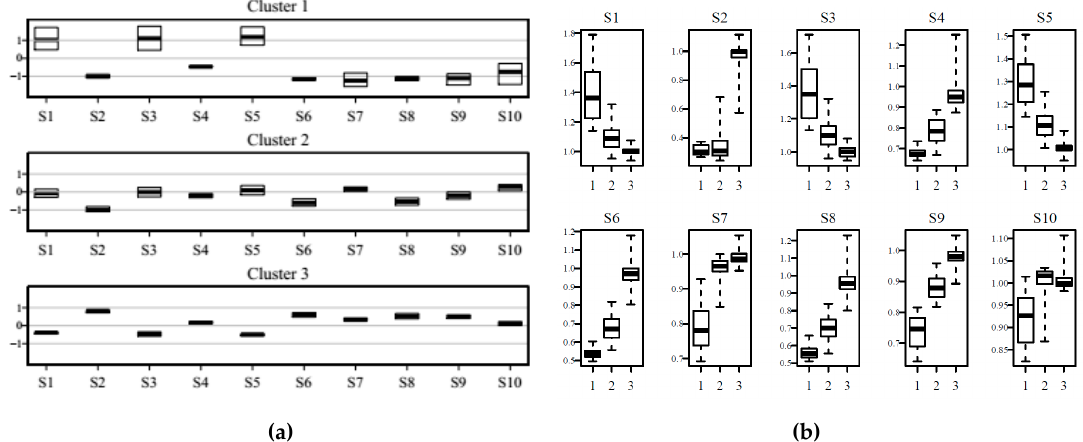
Figure 4. ( a ) Profiles of interquartile ranges and medians of sensor weights for prototypes of the overall dataset belonging to each cluster; variables normalized by sensor and ( b ) boxplots of variability of responses of prototypes of the overall data set for the three clusters for each of the ten sensors